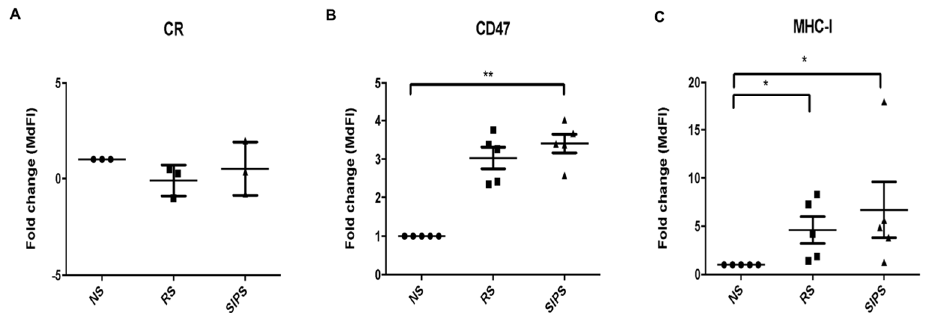
Figure 5. Calreticulin, CD47, and MHC-I expression. The figures represent the expression fold change of ( A ). Calreticulin, ( B ). CD47, and ( C ). MHC-I expression in NS (black circle), RS (black square), and SIPS (black triangle) performed as described in materials and methods. Each bar represents the mean ± SEM of independent experiments, three for Calreticulin and five for CD47 and MHC-I (* p <0.05, ** p < 0.01, Kruskal–Wallis-Dunn